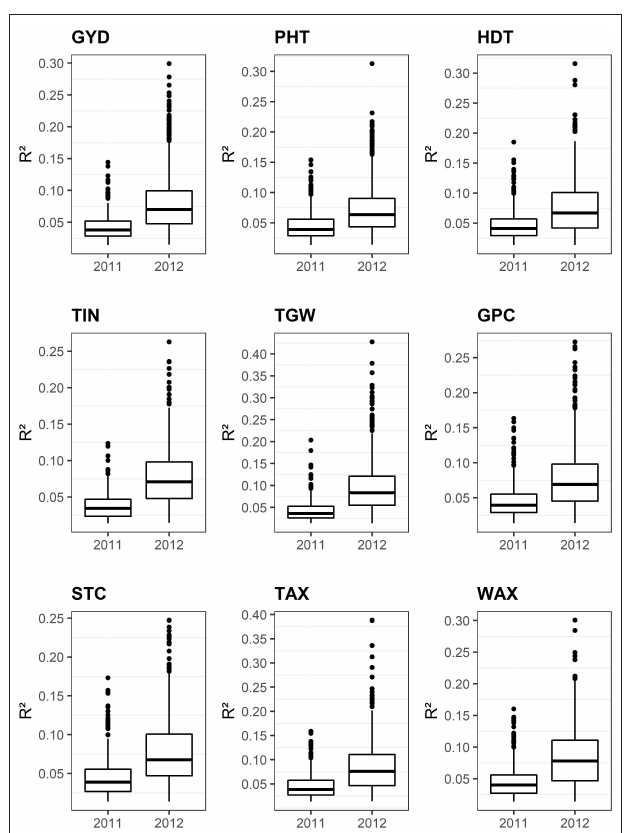
FIGURE 9 | Box plots illustrating the phenotypic variances (R 2 ) explained by individual associated SNPs. GYD, grain yield; TGW, thousand-grain weight; PHT, plant height; HDT, heading date; TIN, tiller number; GPC, grain protein content; STC, starch content; TAX, total arabinoxylan content; WAX, water extractable arabinoxylan